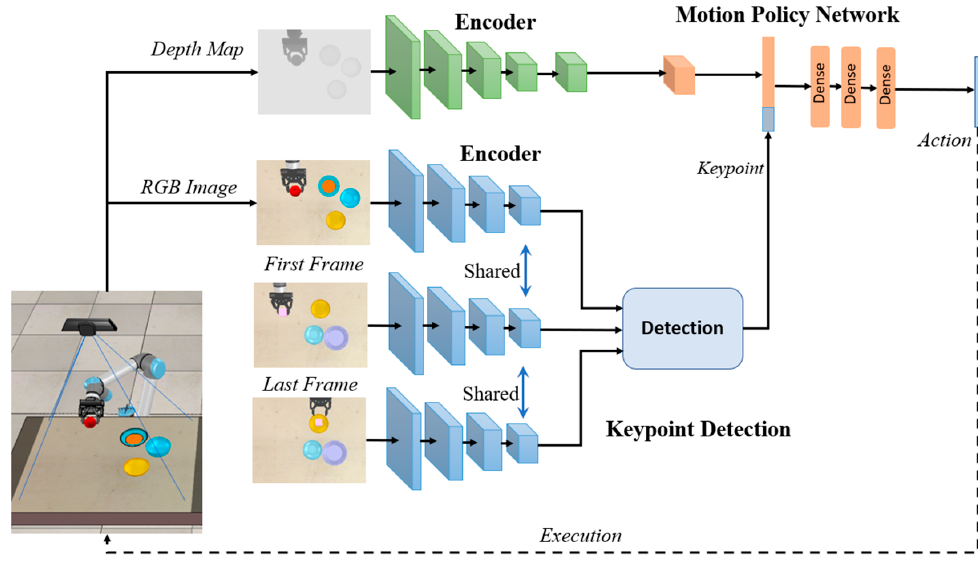
Figure 1. The main framework of the proposed method.